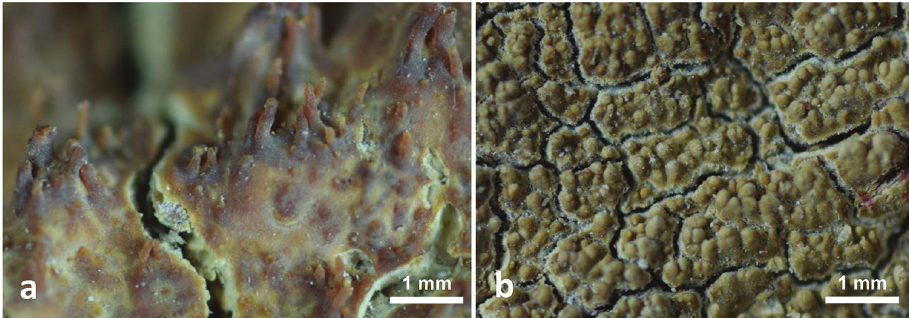
Figure 3. Basidiocarp surfaces a Hydnophanerochaete odontoidea (holotype of Phanerochaete subodon- toidea , CWN 00776 ) b Odontoefibula orientalis (holotype, Wu 0910-57 ). Scale bar: 1 mm.